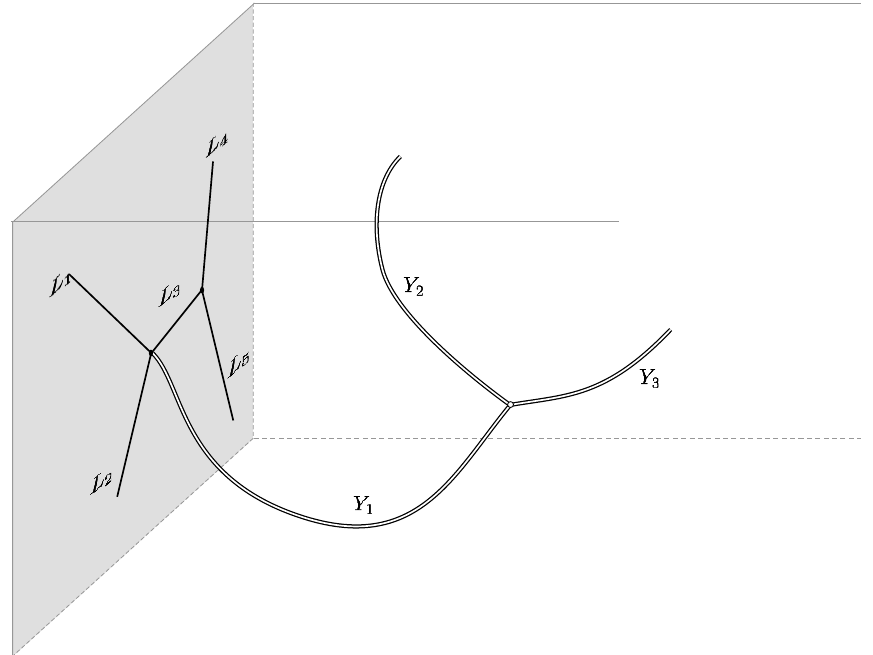
Figure 5 . A topological (cid:12)eld theory with a gapped boundary condition. Boundary lines are labelled by objects L i in a spherical fusion category C which controls their topological fusion and junctions. Bulk lines are labelled by objects Y a in a modular tensor category which can be recovered as the Drinfeld center Z [ C ] of the boundary lines. Junctions of lines are labelled by choices of local operators, i.e. elements in certain morphism spaces. We use a double-line notation to indicate the dependence of bulk lines on a choice of framing. The partition function can be computed by a Turaev-Viro state